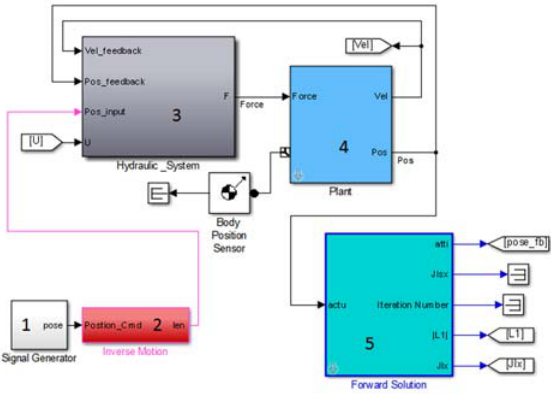
Figure 3. The simulink ® Model of the Stewart manipulator. Table 1. Configuration parameters of the Simulink ® model.